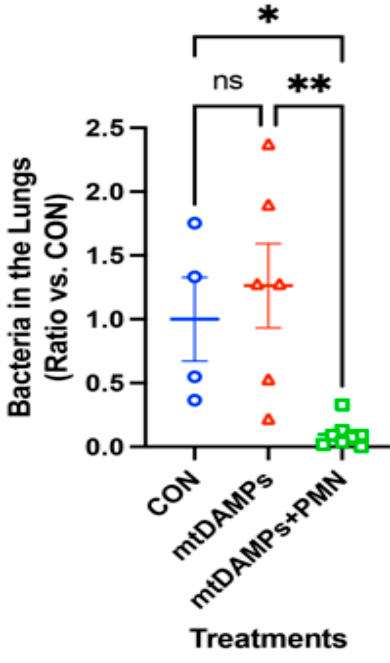
Figure 3. Effects of exogenous PMN on clearance of Pseudomonas pneumonia. Protocols are similar to Figure 2; however, an increased number of P. aeruginosa (OD = 0.111) was injected to the lungs.